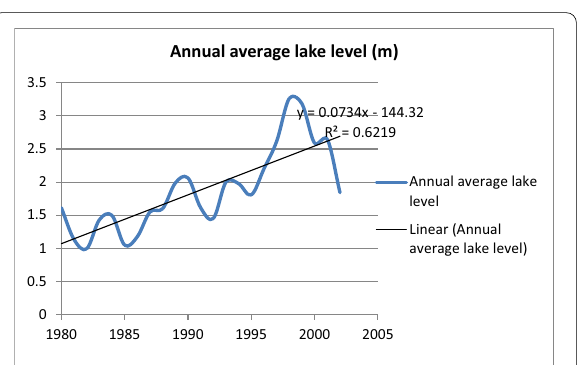
Fig. 9 Water level of Lake